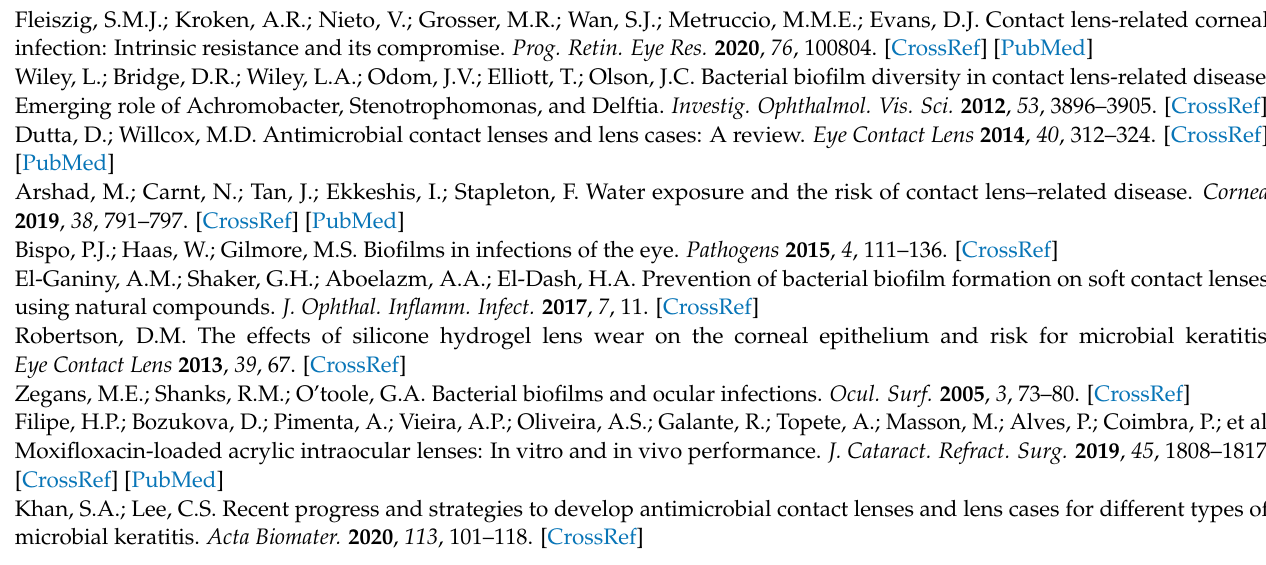
Figure S3: Water uptake (%) of silicone and HEMA hydrogels in water, SLF and resveratrol load- ing solution; Figure S4: Water contact angles on the silicone-based hydrogels and HEMA-based hydrogels; Figure S5: Reading test for silicone and HEMA hydrogels; Figure S6: SEM images of freeze-dried hydrogels recorded at high magnification (50,000 × ); Figure S7: Images of the HET-CAM test; Figures S8–S11: Normalized shift in the frequency, ∆ f/n, and shift in the dissipation, ∆ D, for the third harmonic of the resonant frequency of quartz crystal sensors coated with S1, S4, S5, S6, H1, H4, H5 and H6 hydrogel films after addition of albumin or lysozyme; Figure S12: Antioxidant activity of resveratrol released from silicone hydrogels and their respective controls; Figure S13: Antioxidant activity of resveratrol released from HEMA hydrogels and their respective controls; Figure S14: Antioxidant activity of a 100 µ g/mL resveratrol in ethanol:water 10:90 v / v solution, NaCl 0.9% and DPPH 0.1 mM